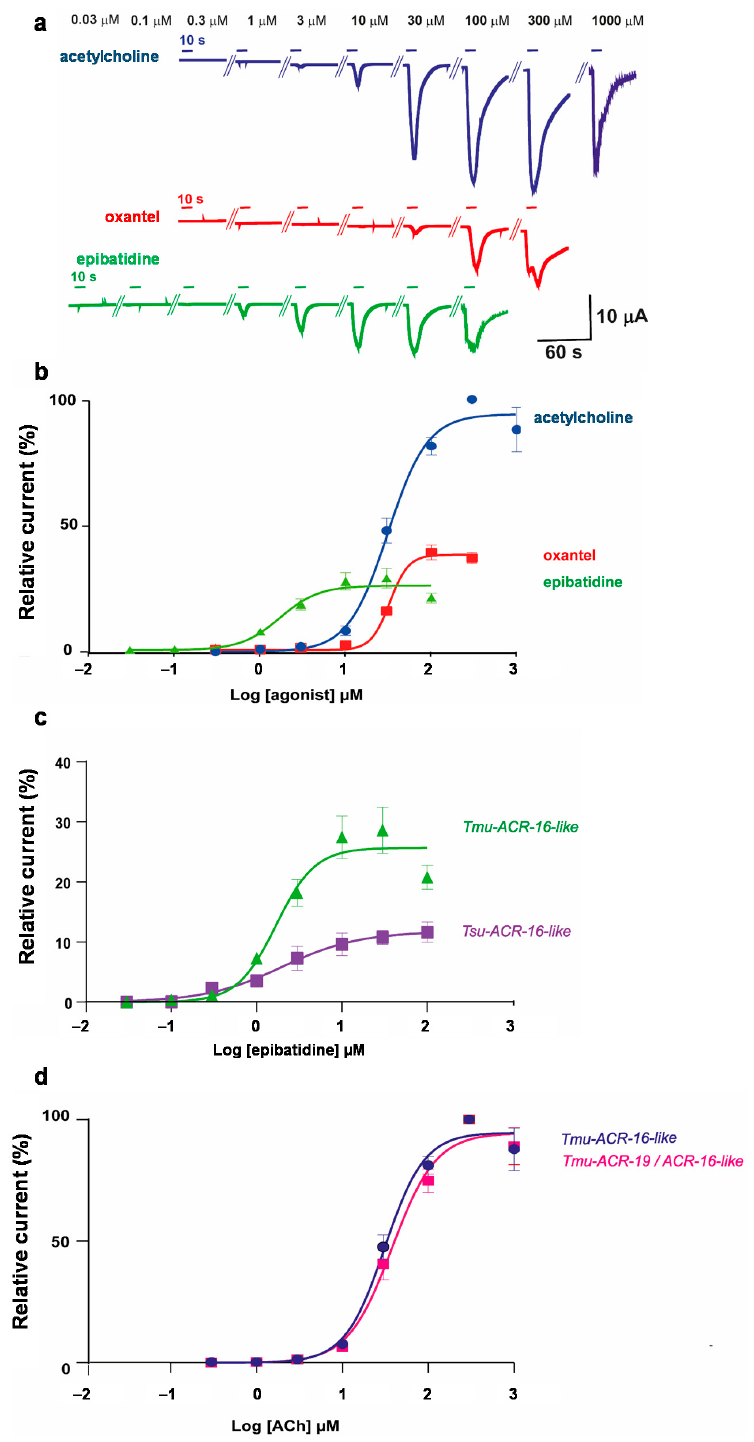
Figure 3. Concentration-response relationships. ( a ) Representative current traces of individual Xenopus oocytes expressing the Tmu -ACR-16-like receptor challenged with increasing concentrations of ACh (blue), oxantel (red) and epibatidine (green). Compounds were applied for 10 s (short bars); ( b ) Concentration-response curves of ACh, oxantel and epibatidine on the Tmu -ACR-16-like receptor; ( c ) Concentration-response curves for epibatidine on the ACR-16-like receptor from T. muris (also shown in a ) and T. suis ; ( d ) Concentration-response curves for ACh on eggs microinjected either with Tmu-acr-16-like cRNA (also shown in a ) or with Tmu-acr-16-like and Tmu-acr-19 cRNAs. All current responses are normalized to current responses induced by 300 µ M ACh and given as mean ±